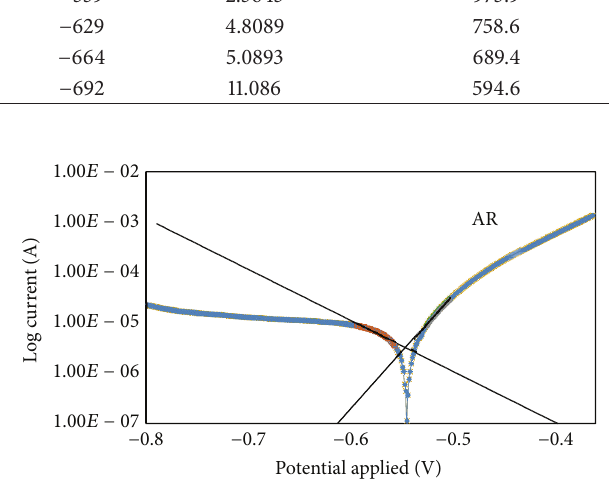
Figure 3: Determination of polarization parameters by Tafel extrap- olation method (e.g., as received